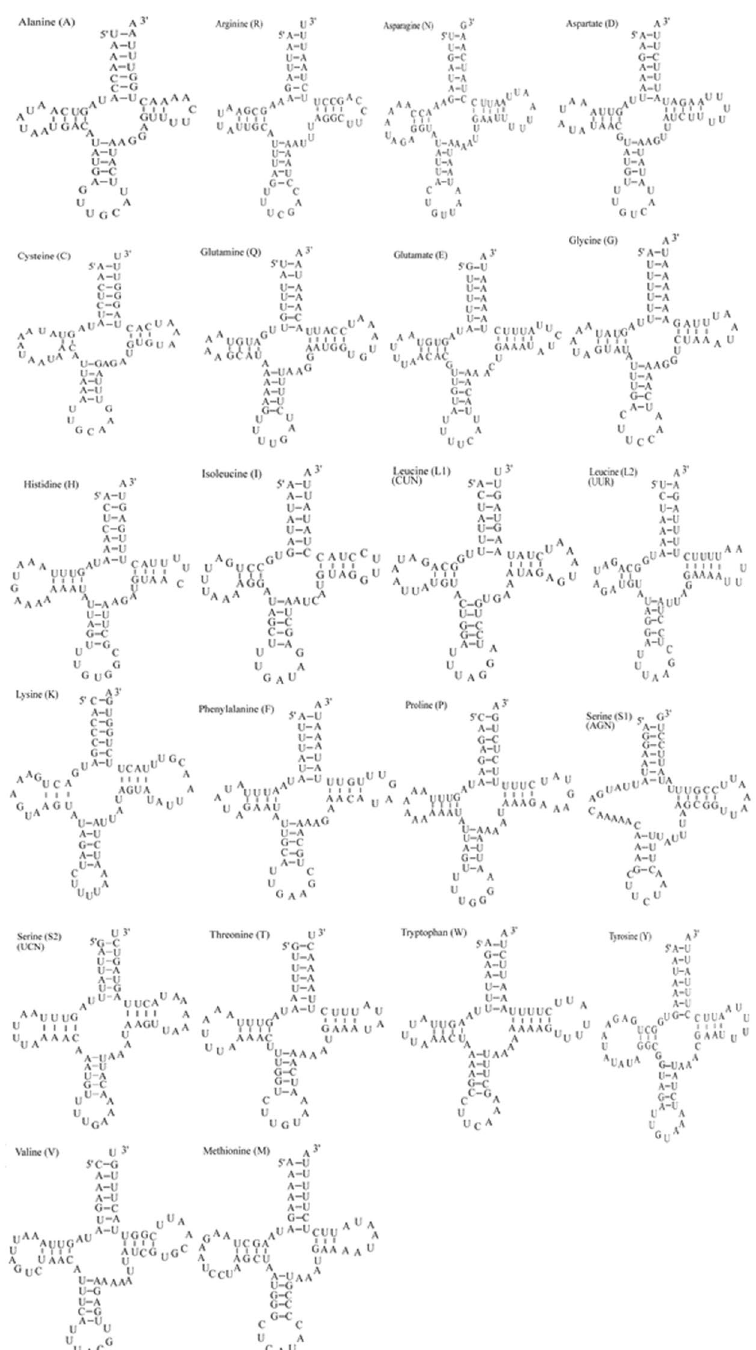
Figure 3. Secondary structures of the 22 transfer RNA genes of Clistocoeloma sinensis . The tRNAs are labelled with the abbreviations of their corresponding amino acids. Dashes ( − ) indicate Watson-Crick